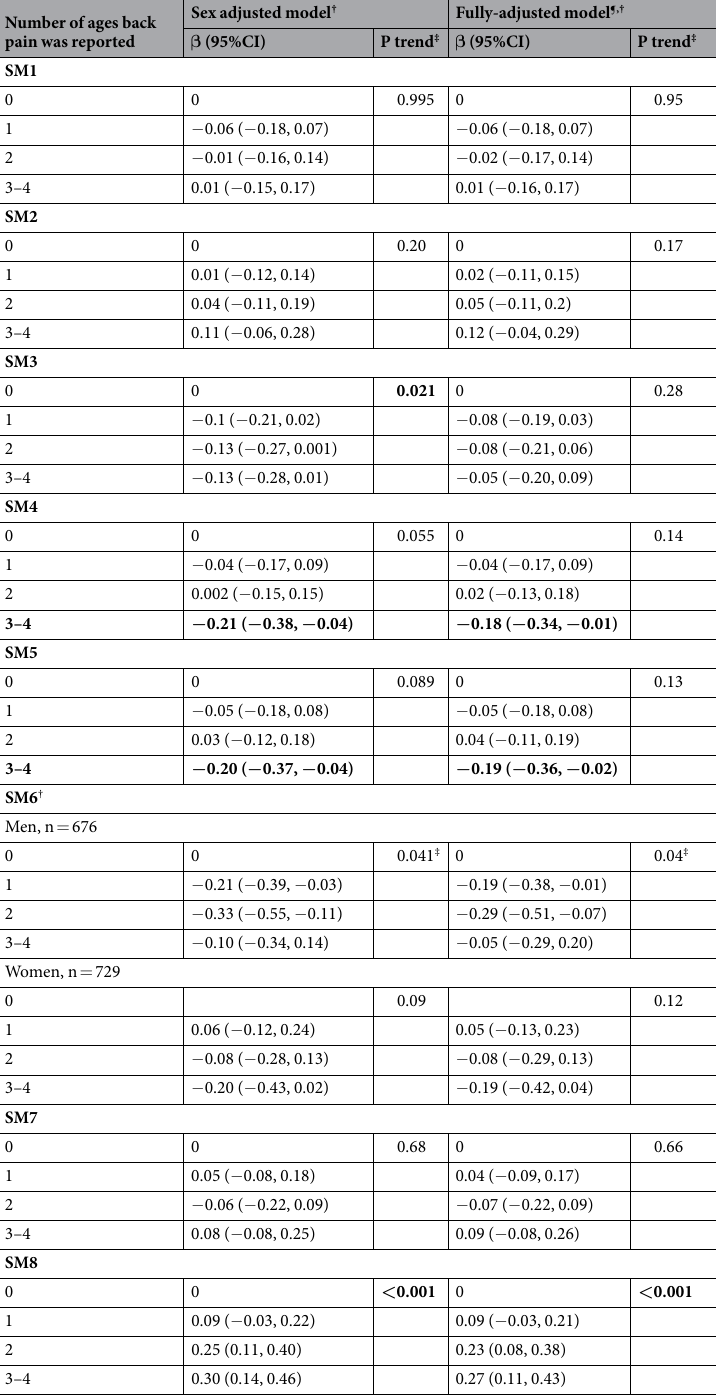
Table 3. Associations between cumulative back pain score and spine modes (N = 1405). SM: spine mode. † Combined analyses presented except mode 6 which was sex-stratified, sex-interaction, p = 0.048 (unadjusted model); ‡ p value for test of heterogeneity across groups when there was evidence of a deviation from a linear trend; ¶ adjusted for sex, current BMI, spine aBMD, own occupational class, physical activity, GHQ-28 and number of